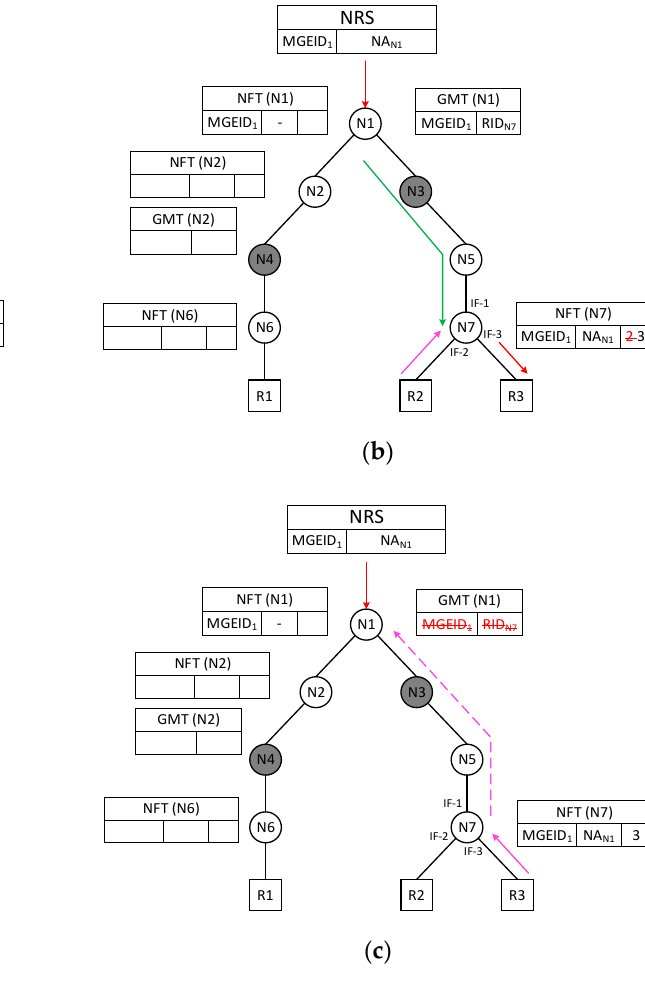
Figure 6. The example of the leave process in AHHM. ( a ) R1 leaves the multicast group; ( b ) R2 leaves the multicast group; ( c ) R3 leaves the multicast group.